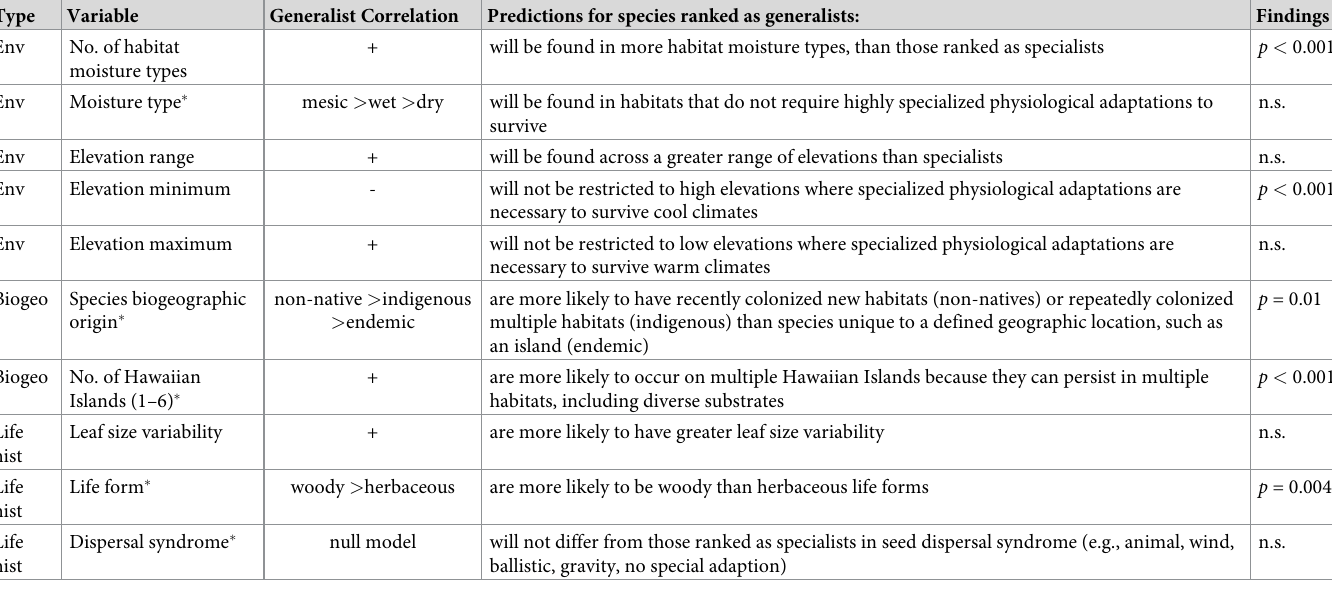
Table 4. Findings from tests to validate species habitat specialization rankings and efforts to identify the predictability of species’ traits along the habitat specializa- tion continuum. Type Variable Generalist Correlation Predictions for species ranked as generalists: